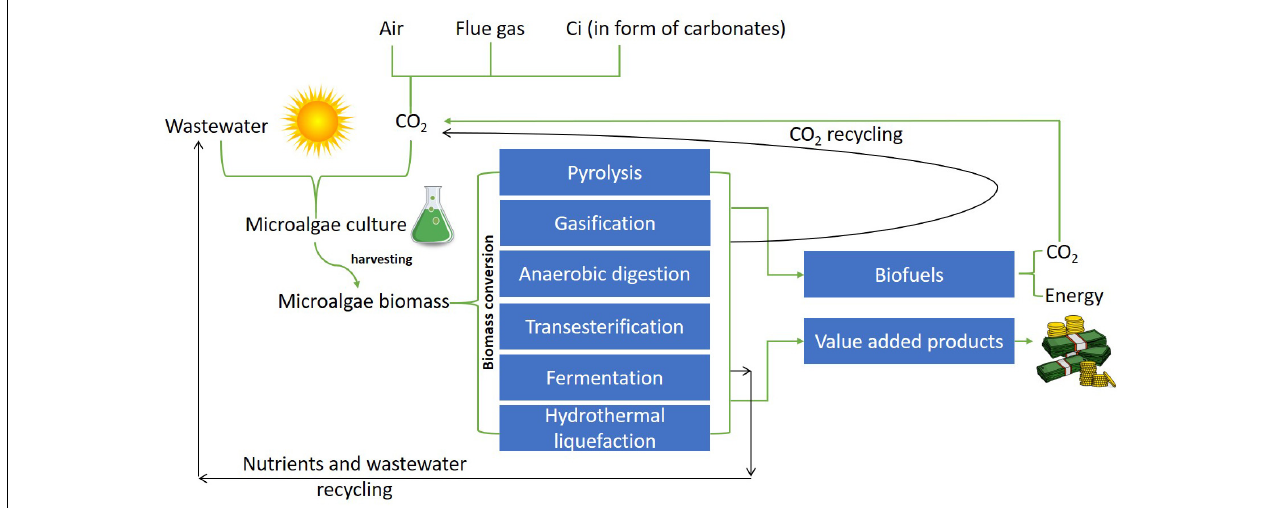
FIGURE 1 | A simplistic representation of microalgal based biorefinery